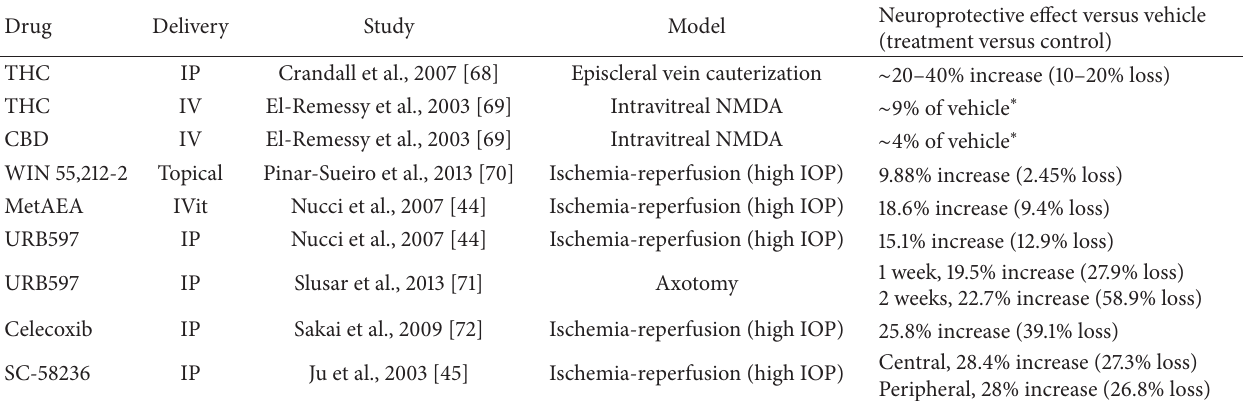
Table 1: Studies investigating cannabinoid-mediated neuroprotection in models of glaucoma.